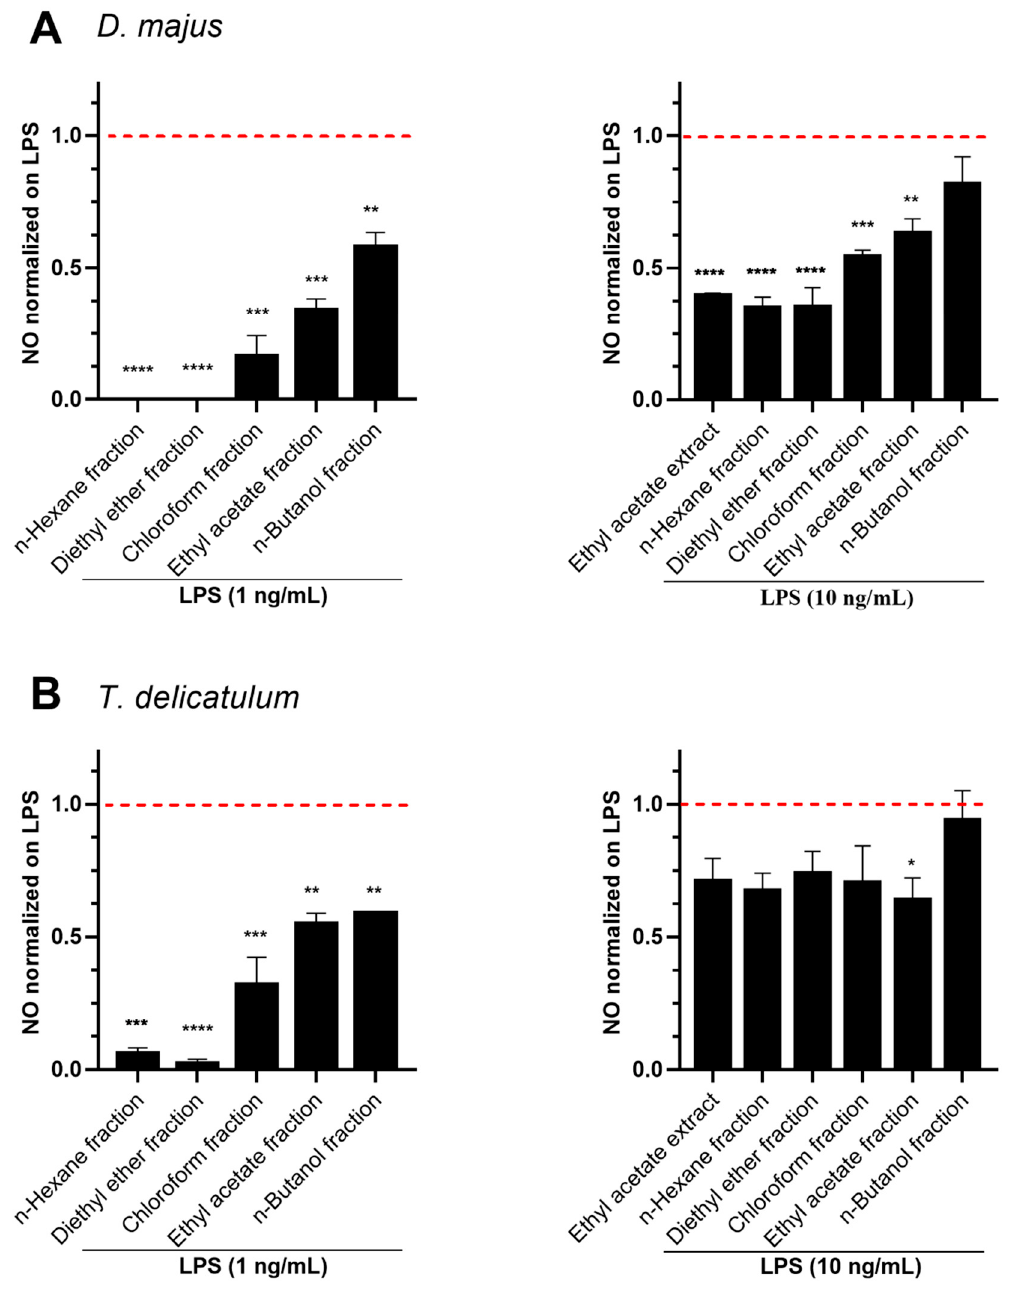
Figure 6. Effect of the fractions of the ethyl acetate crude extracts from ( A ) D. majus and ( B ) T. del- icatulum on LPS-induced NO in RAW264.7 cells. Cells pre-treated with 10 µg/mL of extracts for 1 h were stimulated with LPS at 1 ng/mL or 10 ng/mL for 18 h. The NO content of the culture medium was analyzed by the Griess reagent method. Data represent mean ± standard deviation (n = 2–3). Values are normalized on LPS. The tested extracts revealed a significant difference with p -values < 0.05, calculated with ANOVA. * p < 0.05, ** p < 0.01, *** p < 0.001, **** p < 0.0001 indicate significant differences compared to the control. The dashed line represents the level of NO in cells stimulated by LPS alone.